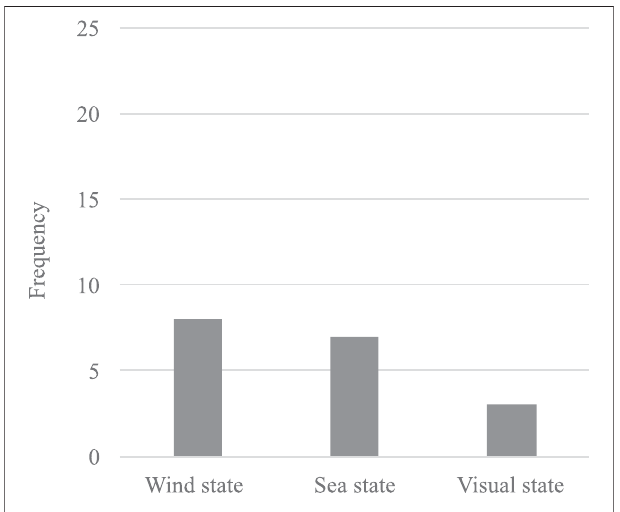
FIGURE 7 | Bar chart of the environmental data